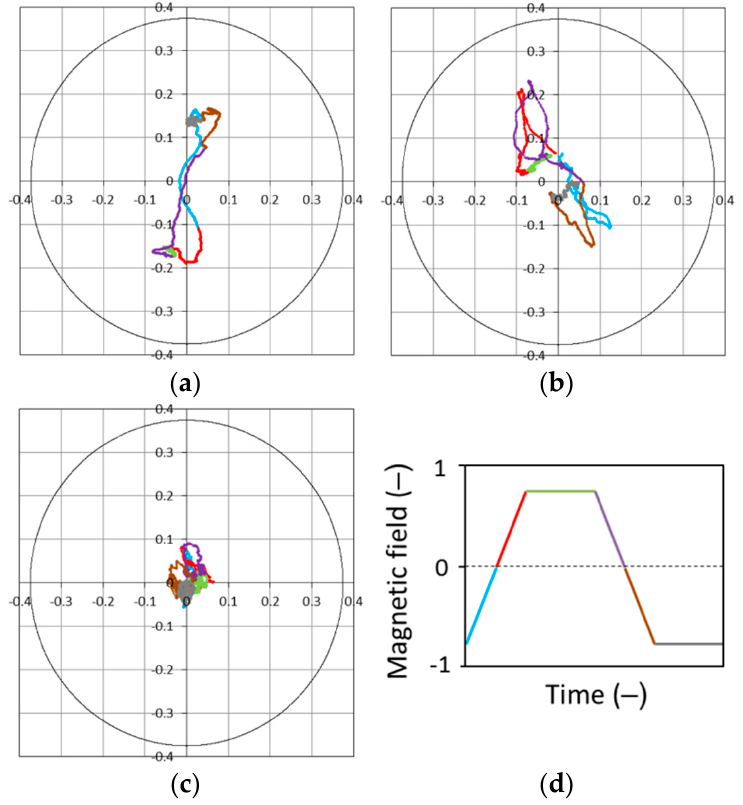
Figure 3. Typical trajectory of the arc centroid during a single stirring period: ( a ) pattern A, ( b ) pattern B, ( c ) pattern C and ( d ) color code of the precise moment in the stirring sequence. (Reproduced from [1], with permission from Elsevier, 2022).